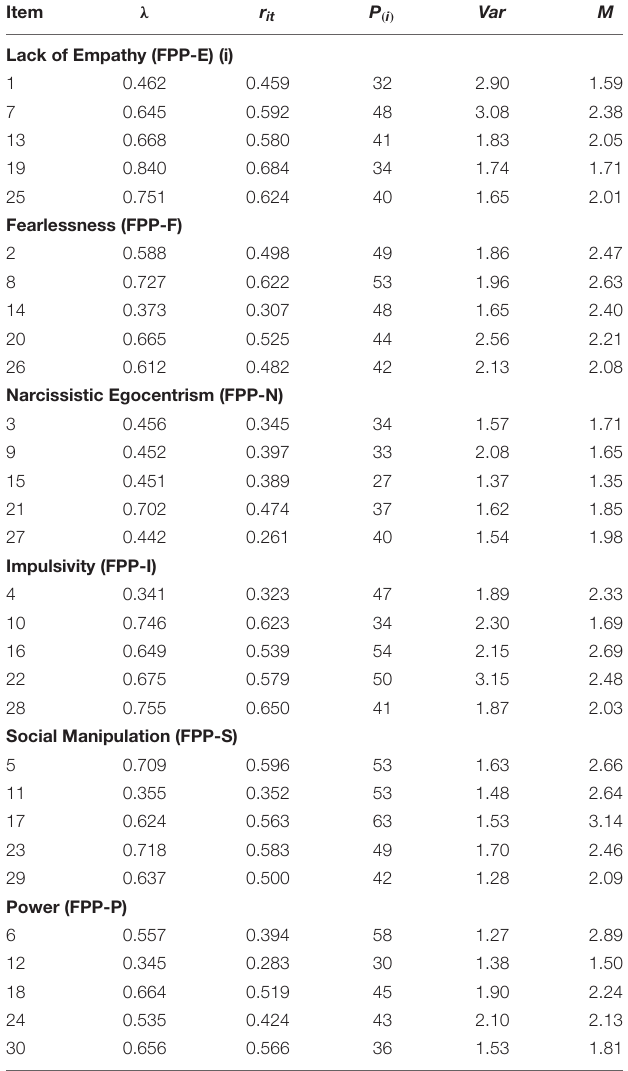
TABLE 2 | Item characteristics of the FPP items ( N =